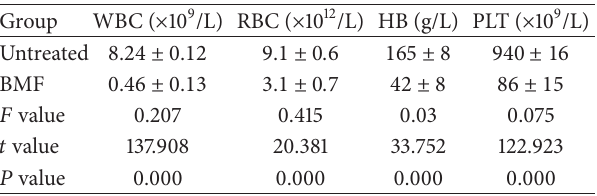
Table 1: Complete blood cell count in untreated and BMF group ( 𝑛 = 10 ). Group WBC ( × 10 9 /L) RBC ( × 10 12 /L) HB (g/L) PLT ( × 10 9 /L) Untreated 8.24 ± 0.12